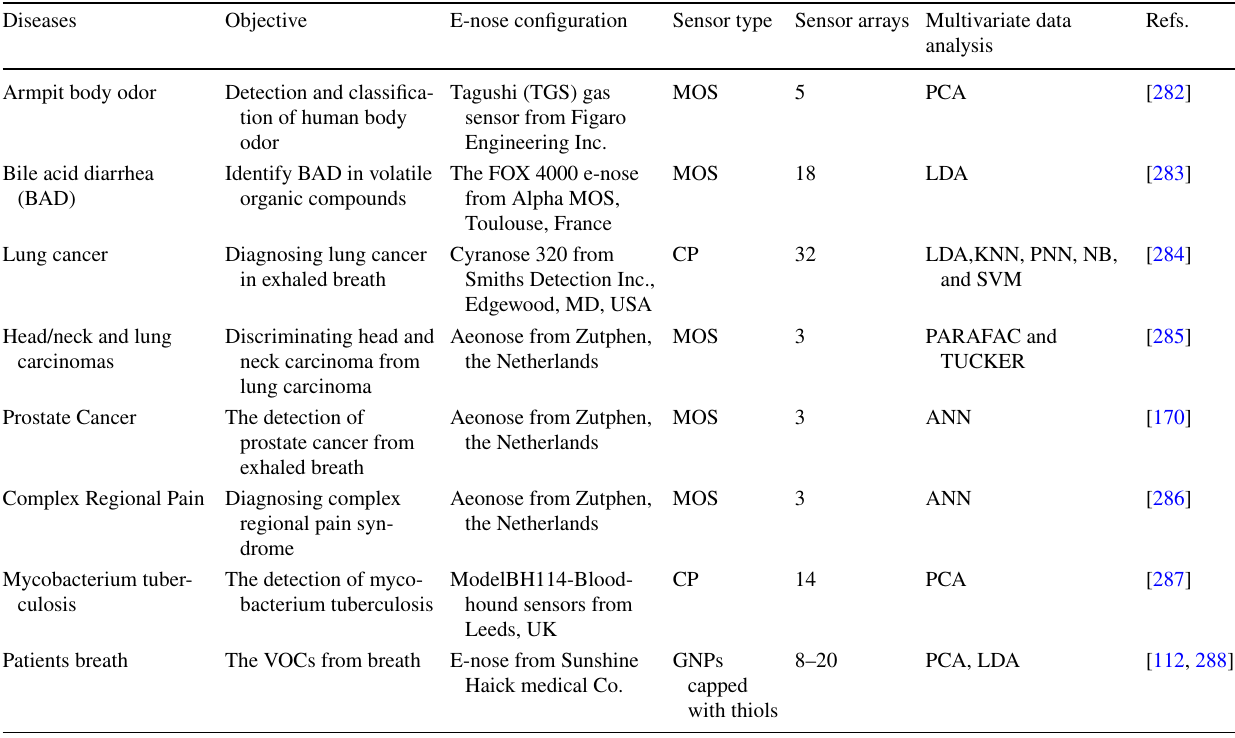
Table 8 Applications of electronic nose instruments for disease diagnosis